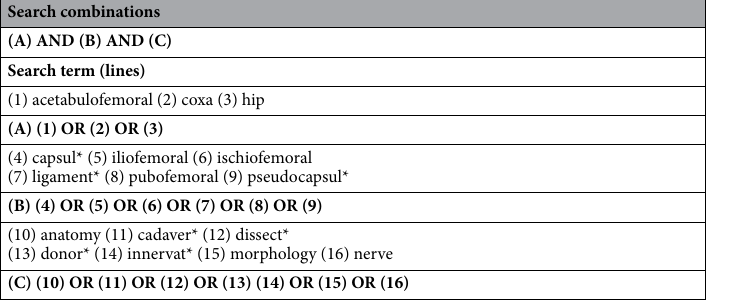
Table 1. Search terms used in search strategy for this systematic review. Using the Boolean search method, the search lines were combined with the word ‘AND’. *Truncation of a word, this searches for words that begin with the word preceding the